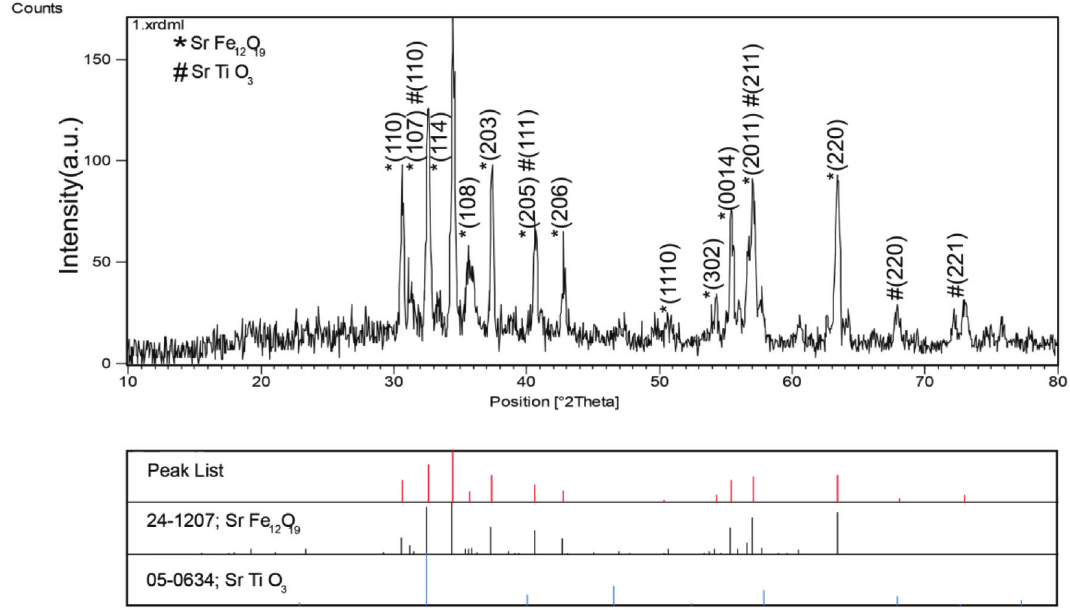
Figure 4: XRD patterns of SrFe